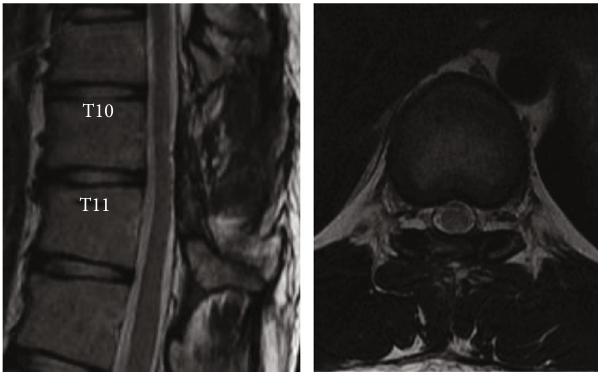
Figure 4: Magnetic resonance imaging one year after operation shows a completely resected and well-decompressed spinal